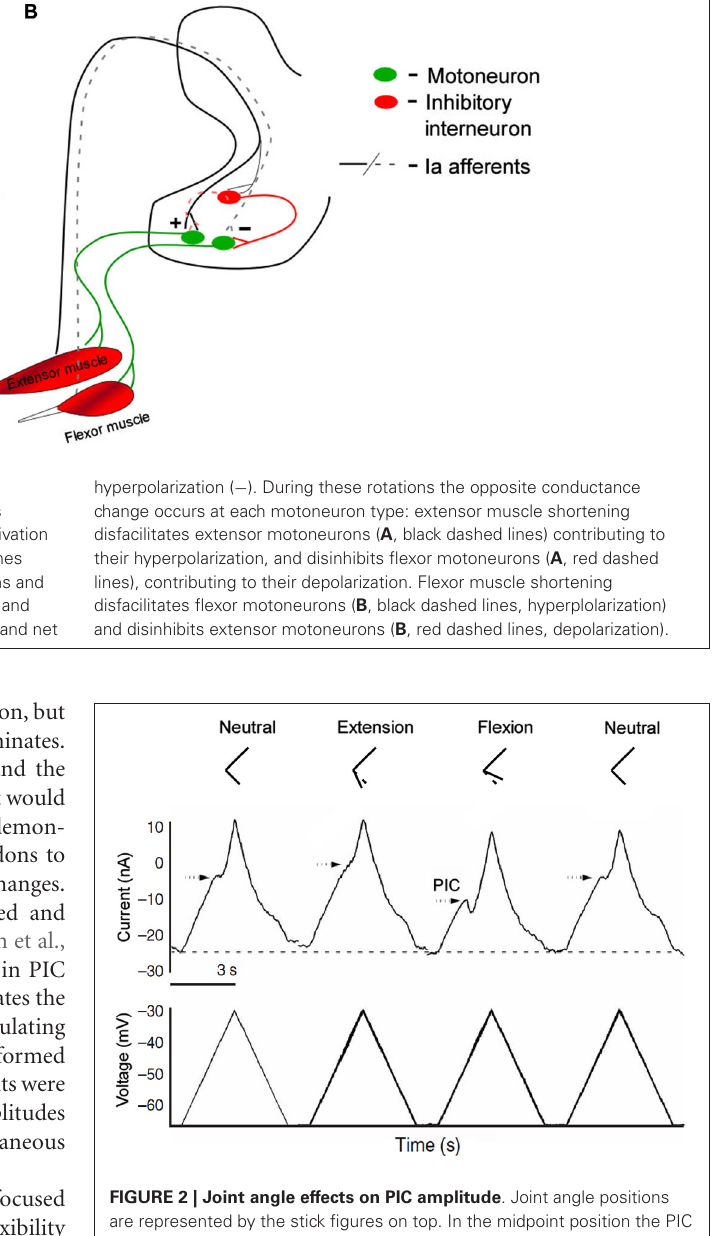
FIGURE 2 | Joint angle effects on PIC amplitude . Joint angle positions are represented by the stick figures on top. In the midpoint position the PIC is clearly present as a downward deflection (indicating an inward depolarizing current) in the current trace. During extension, inhibition from antagonist muscle stretch greatly reduces PIC amplitude in the recorded extensor motoneuron. During flexion, antagonist muscles are shorter than in the midpoint position, providing disinhibition to extensor motoneurons revealing a large